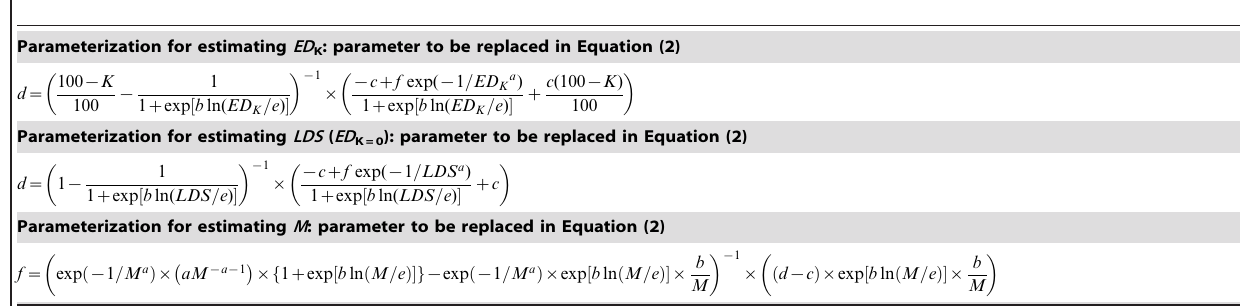
Parameterization for estimating ED K : parameter to be replaced in Equation